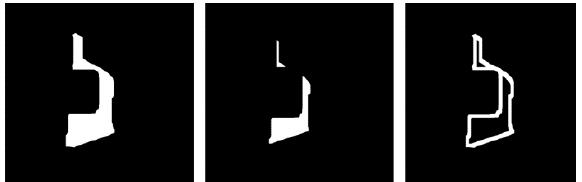
Figure 5. Target Seed Area Extraction from 3D data. 2.2.3 Seed Background Extraction : Since the background area is larger than target area, we need to find area outside the model boundary as